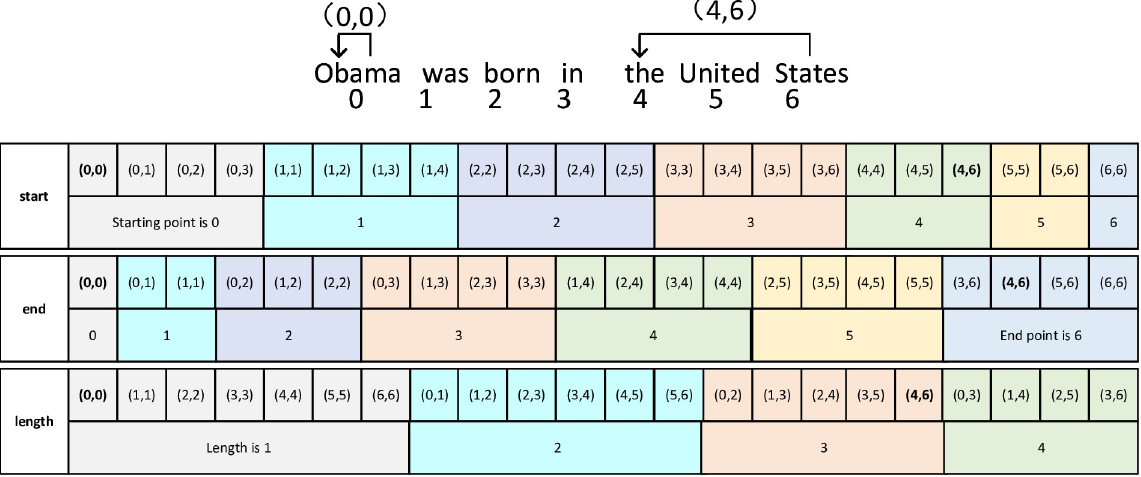
more perfectly. The span tagger enables the token position index tuple to correspond to its constituent span position indexes quickly. It enables the subsequent construction of the span semantic vectors to be combined into a span-embedding matrix according to the results of the span-tagger, which facilitates the subsequent selection of span multi-headed relations.